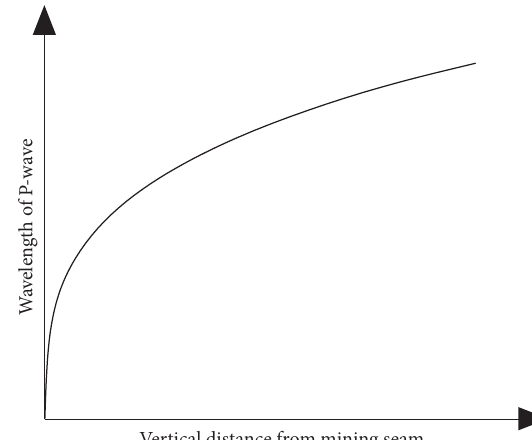
Figure 4: The relationship between the longitudinal wave length and the distance from it to the coal seam.